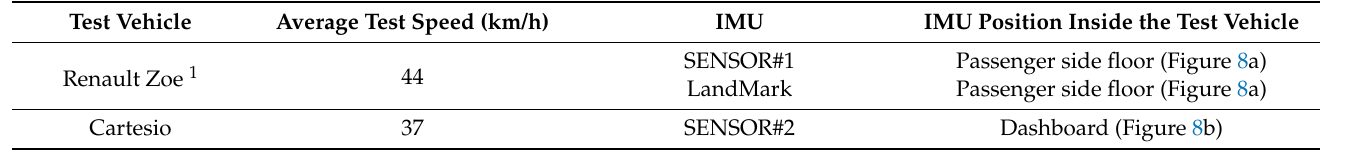
Table 6. Characteristics of the IMUs’ position inside the vehicles during the tests.